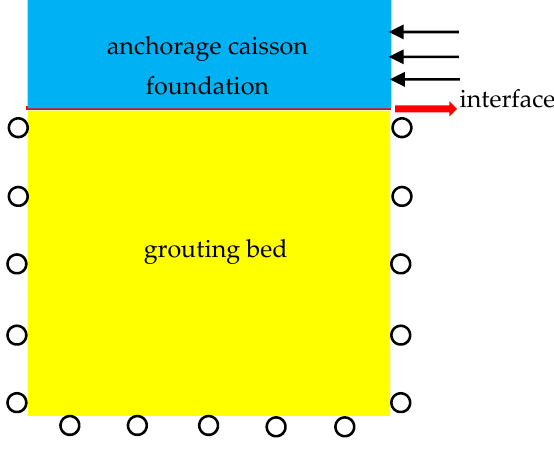
Figure 22. Numerical model.